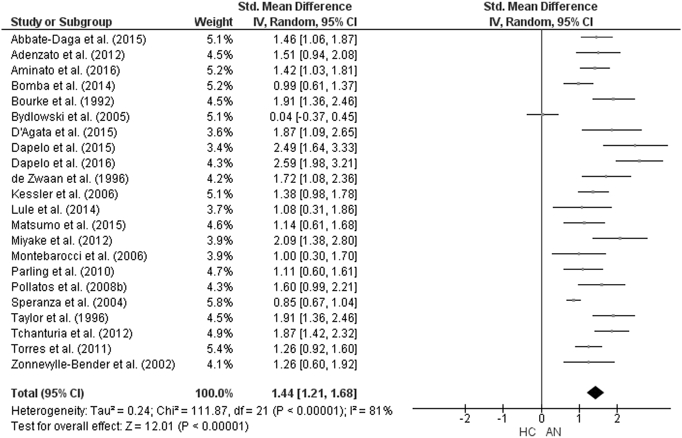
Forest plot of mean TAS score: standardized mean effect size for differences (SMD) between Anorexia Nervosa (AN) and Healthy Controls. CI, confidence interval.